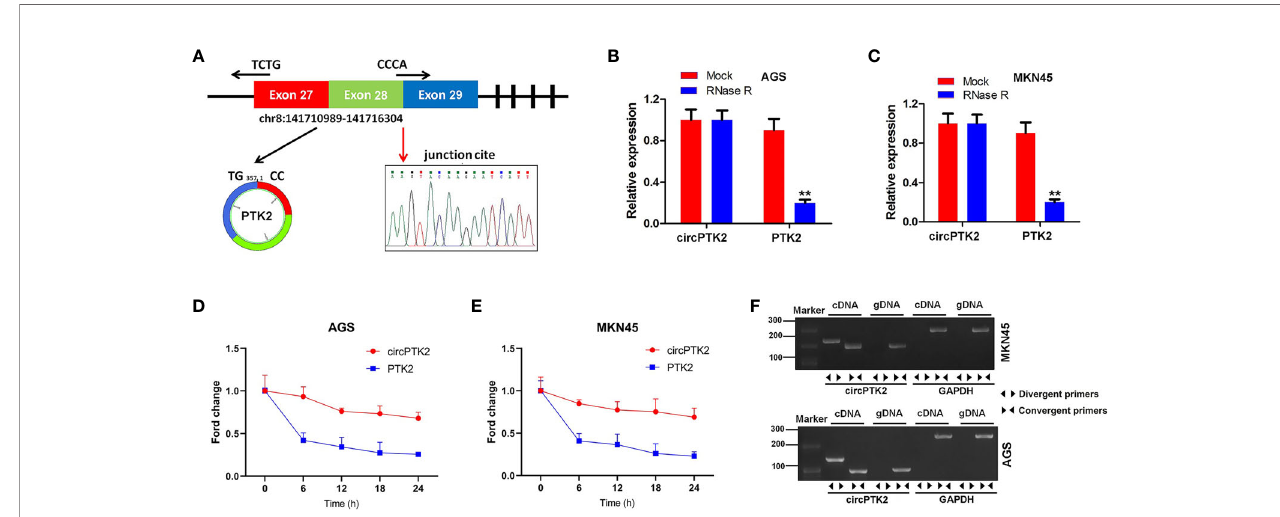
FIGURE 2 | CircPTK2 is a stable circRNA from PTK2. (A) Schematic diagram showed the formation of circPTK2. Sanger sequencing showed the joint site of circPTK2 (red arrow). (B, C) The expression of linear and circRNA linear was detected with RT-qPCR, after RNase R treatment. ** p < 0.05 vs. Mock. (D, E) After actinomycin treatment, the half-lives of linear and circRNAs were detected. (F) The existence of circPTK2 was detected in AGS and MKN45 cells by RT-qPCR with divergent or convergent primers and con fi rmed by gel